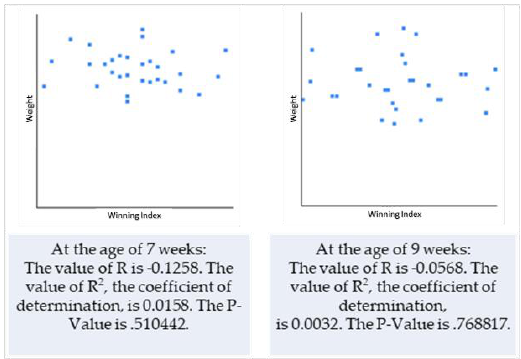
Figure 1. Correlation between the weight of puppies and winning indices—puppy pack 1.